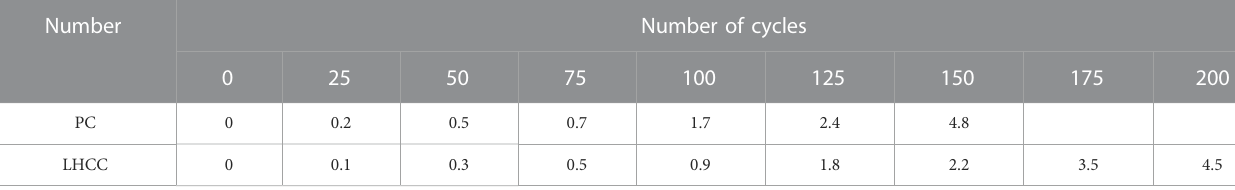
TABLE 5 Mass loss rates during 200 freeze – thaw cycles